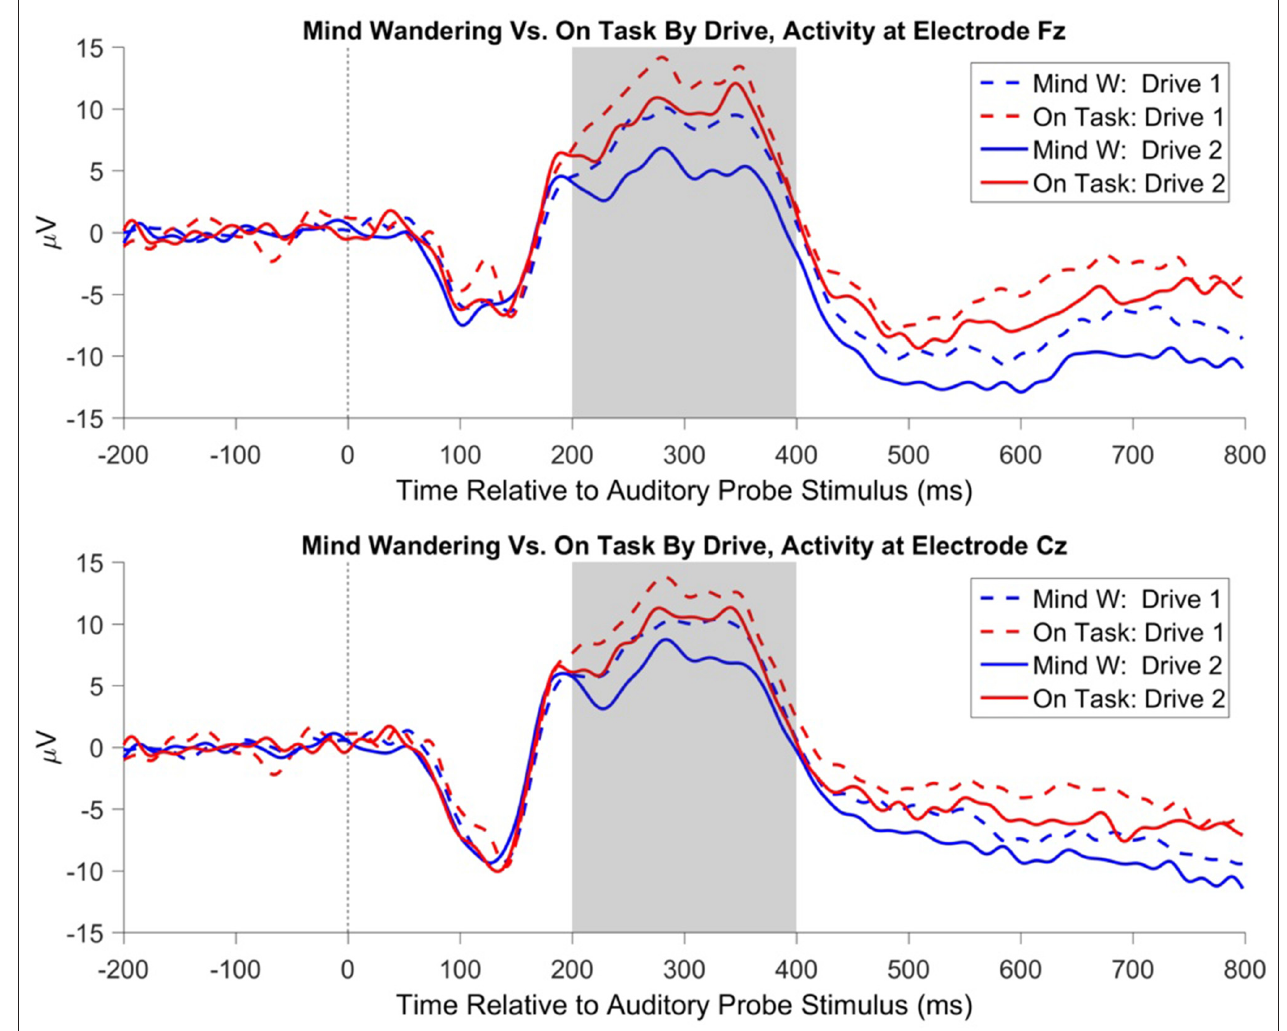
FIGURE 10 | Event related potential (ERP) at electrode Fz to auditory probe tones, separated by participant response and the drive number in which the probe tone occurred. The shaded gray region represents the time-window used to evaluate P3a amplitude. Probe tones presented during periods in which participants responded “on task” have a greater magnitude of P3a relative to probes presented during periods in which participants responded “mind wandering”. In addition, probe tones presented during the first drive of the day have a greater magnitude of P3a relative to probes presented during the second drive of the